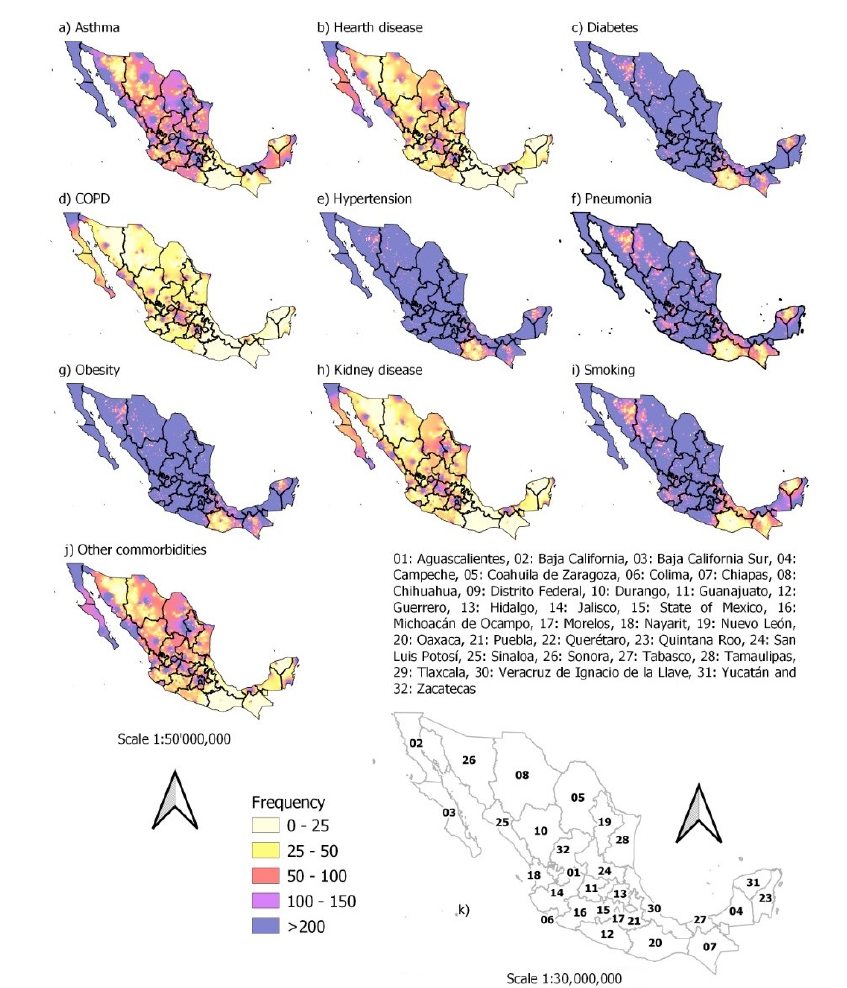
Figure 8. Spatial distribution of comorbidities associated with COVID-19 occurrence from February